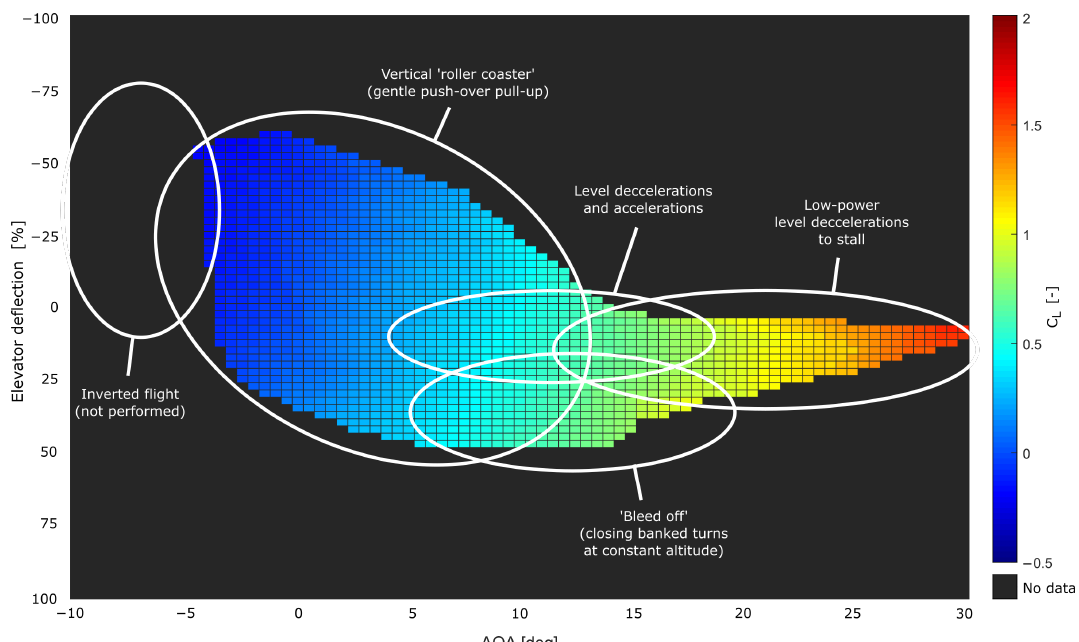
Figure 6. An example of SFT at level 2 for performance evaluation: lift characteristics of the GFF demonstrator identified from a single flight using short dynamic manoeuvres within VLOS.